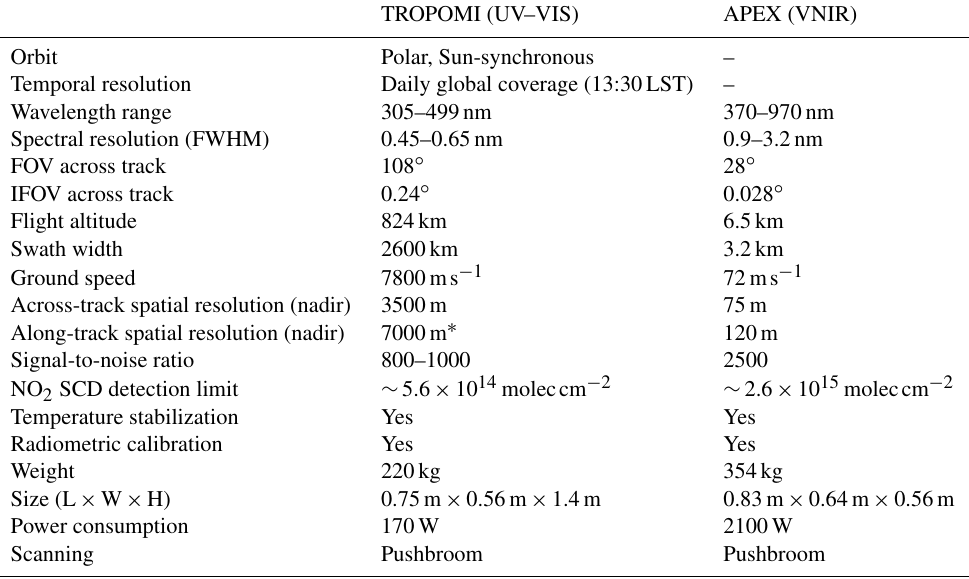
Table 2. TROPOMI and APEX specifications for the S5PVAL-BE campaign, defined for APEX for a nominal altitude of 6.5kma . g . l . Spectrometer characteristics are provided for the APEX visible–near-infrared (VNIR) detector and the TROPOMI UV–VIS channel only. The effective APEX spatial resolution is provided after applying spatial aggregation of the spectra for signal-to-noise